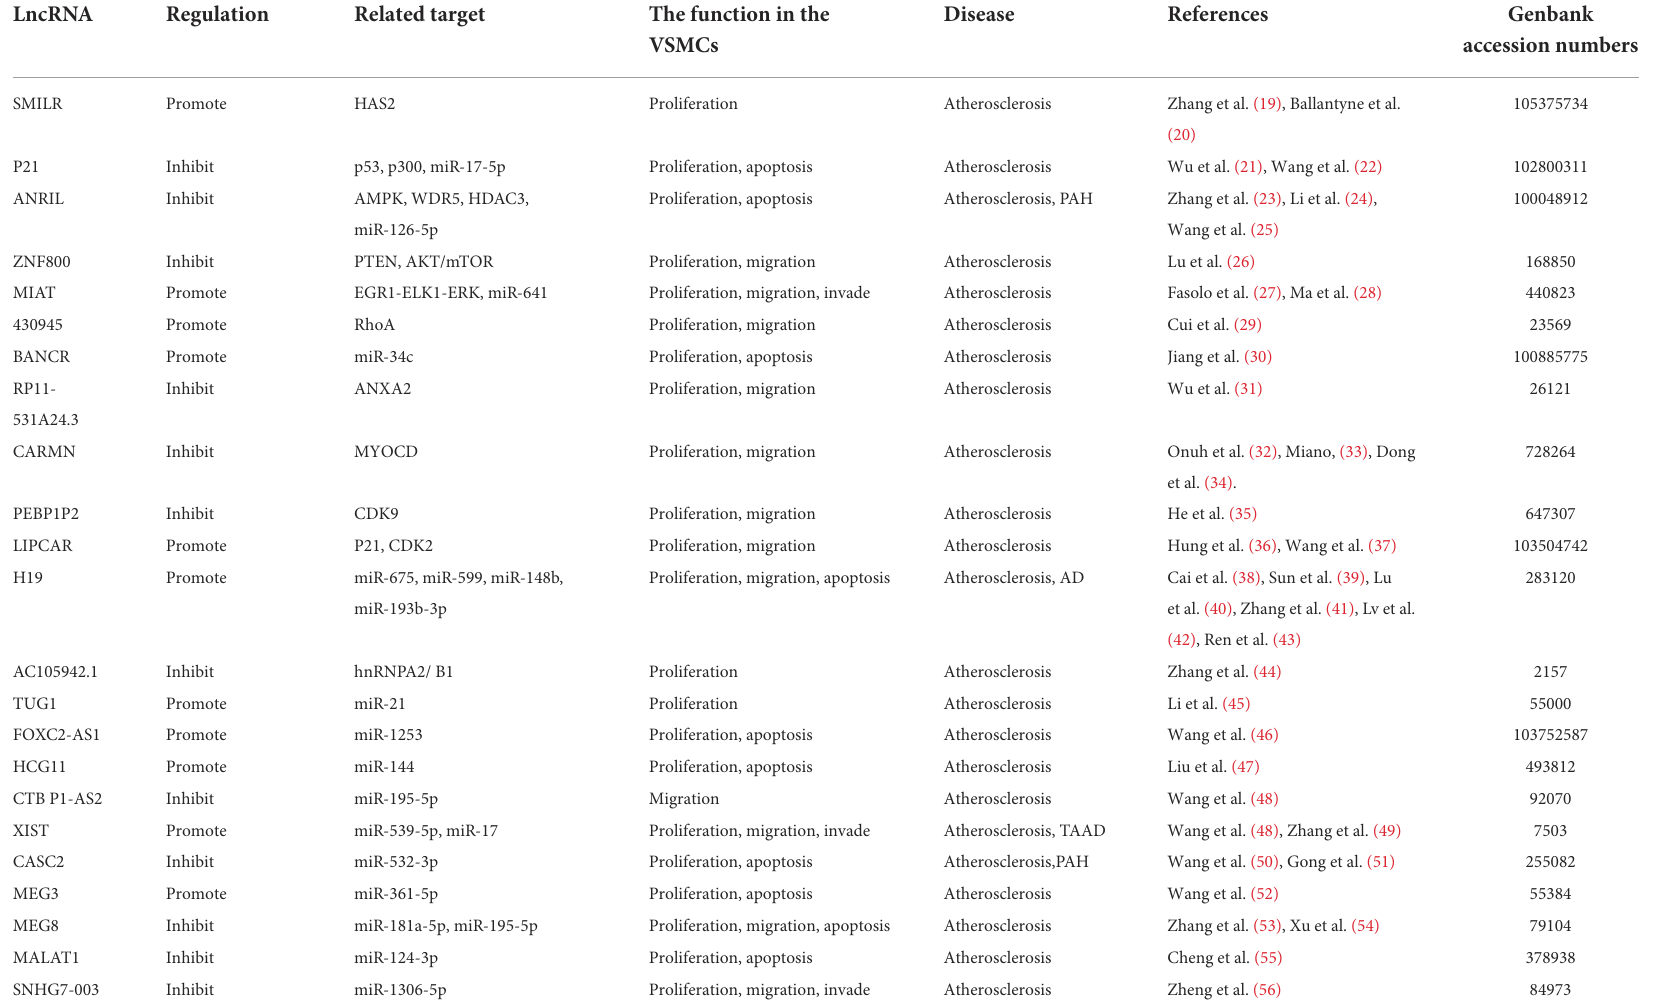
TABLE 1 Long non-coding RNA with functional relevance in different vascular